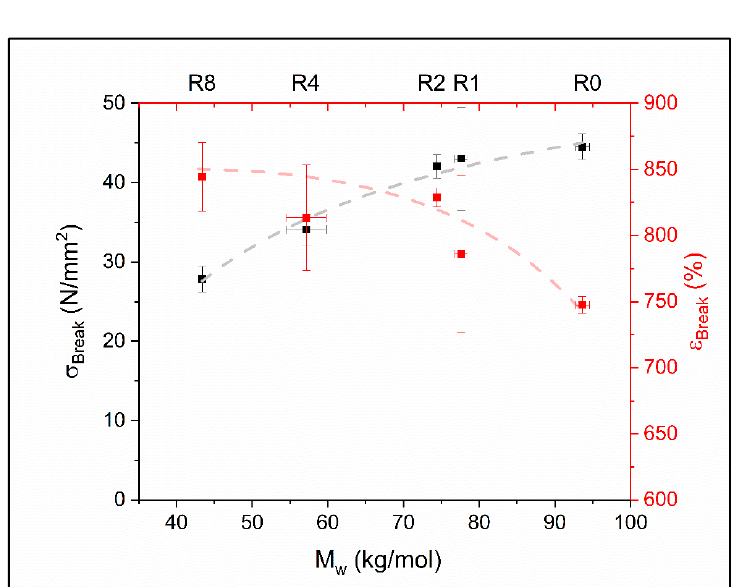
Figure 4. Stress and elongation at break of recycled TPU as a function of weight average molar mass M w . The top axis indicates the recycling step Rx (x = 0, 1, 2, 4, and 8). The red dashed line is a guide to the eye whilst the grey line displays the best fit of Equation